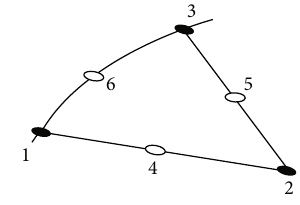
Figure 5: Approximate space for